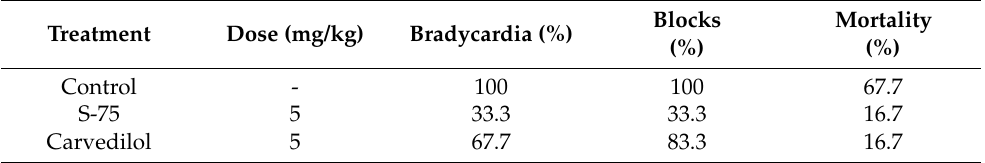
Table 5. The therapeutic antiarrhythmic effect of the tested compound and carvedilol in adrenaline- induced arrhythmia